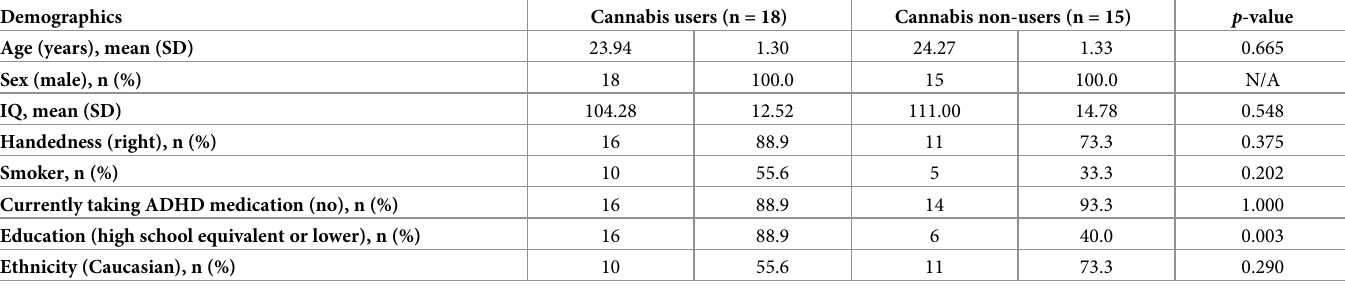
Table 1. Characteristics of adults with childhood